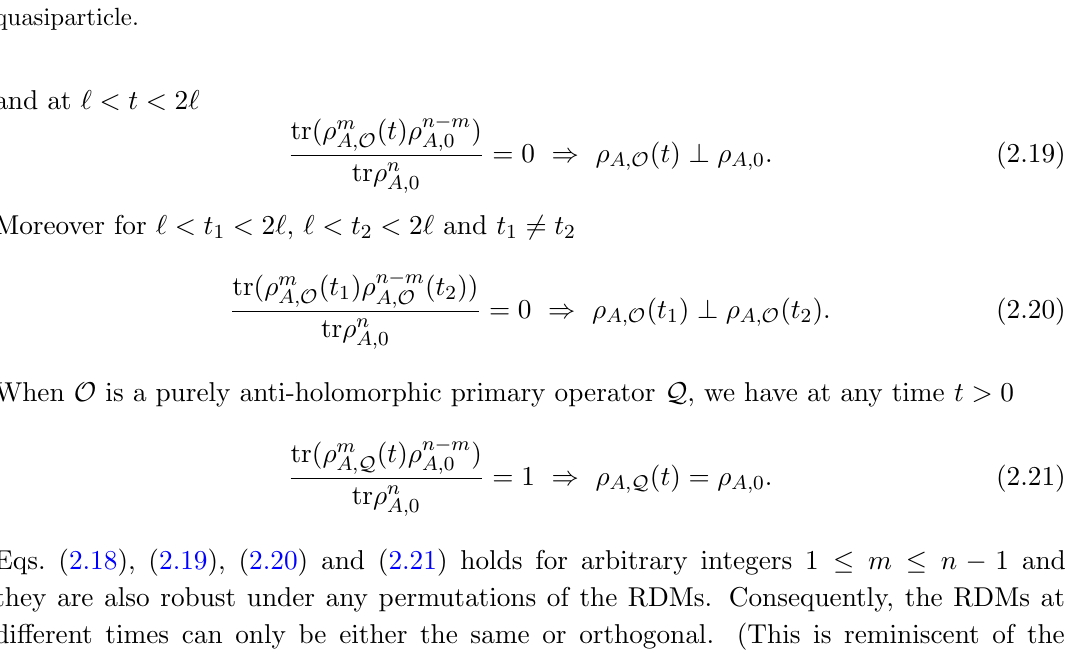
Figure 1 . The division of the values of t 1 ; t 2 into three regions according to the position of the